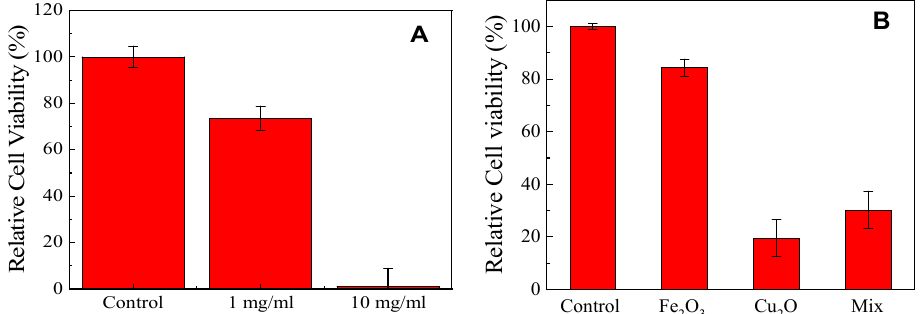
Figure 10. ( A ) Cytotoxicity of the Cu x Fe y O z NPs against mouse fibroblast cells: cell viability after cells exposed to Cu x Fe y O z NPs at 0 mg/mL (control), 1 mg/mL, and 10 mg/mL for 24 h. ( B ) Cytotoxicity of the control NPs against mouse fibroblast cells: cell viability after cells exposed to NPs at 1 mg/mL for 24 h. The results represent 3 independent experiments and are expressed as mean and standard deviations of relative cell viability (compared to control).